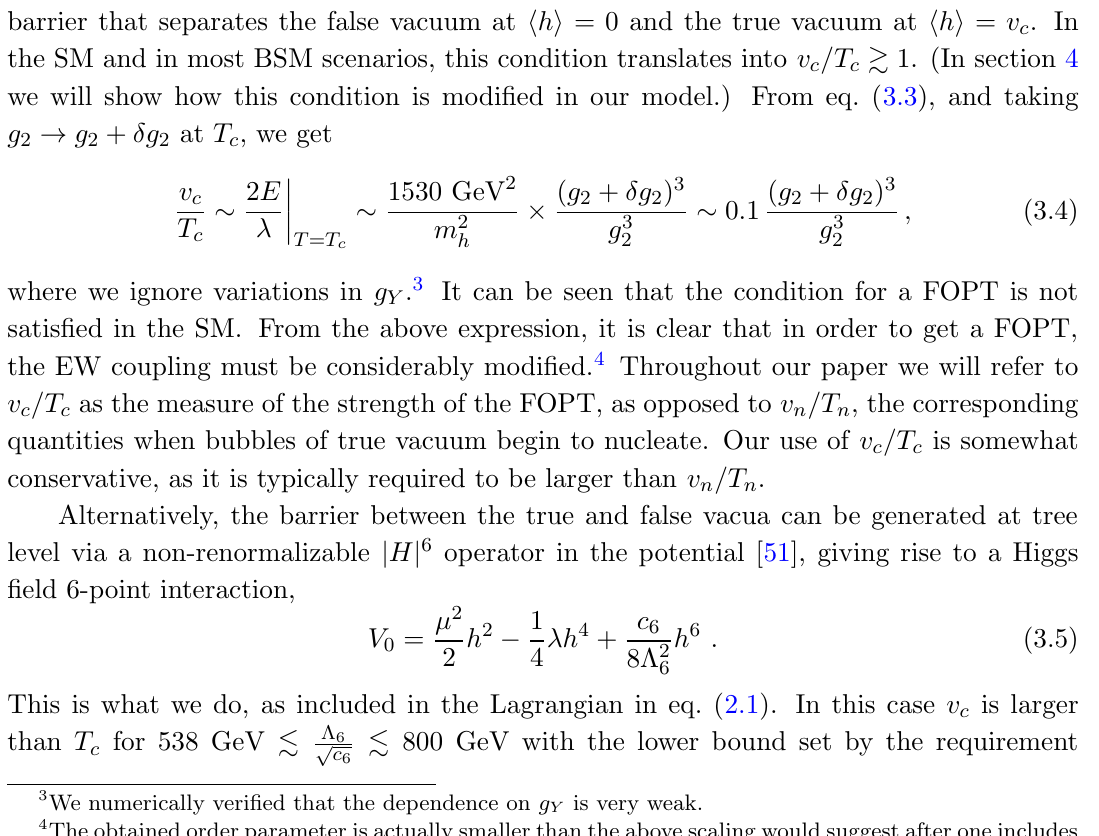
Figure 1 . Ratio of the Higgs vev at the critical temperature T c to the critical temperature as a function of (cid:14)(cid:11) 2 for di(cid:11)erent values of the dimension-6 operator, (cid:3) 6 = dashed line shows the required v c =T c for a (cid:12)rst-order phase transition given (cid:3) 6 = p Changing (cid:3) 6 = c 6 does not a(cid:11)ect this dashed line substantially. For details see section